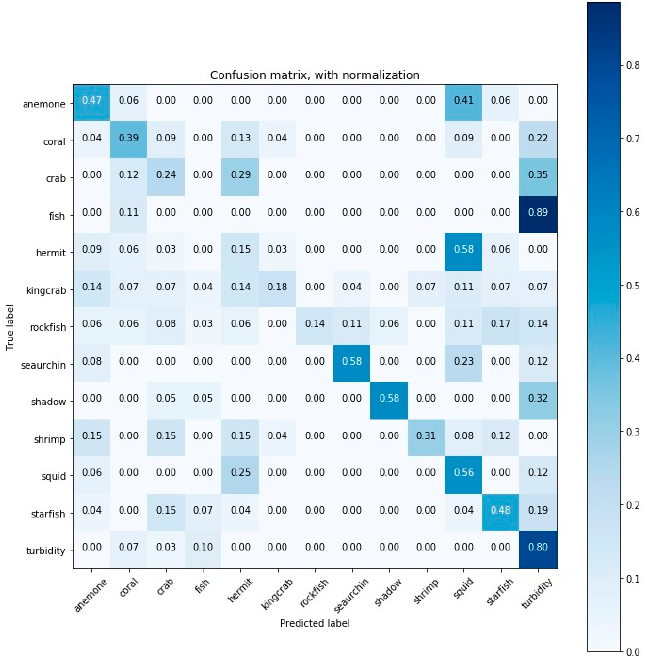
Figure A4. Confusion matrix for the classification results (accuracy) obtained by K-NN (k = 99). Sensors 2020 , 20 , 726